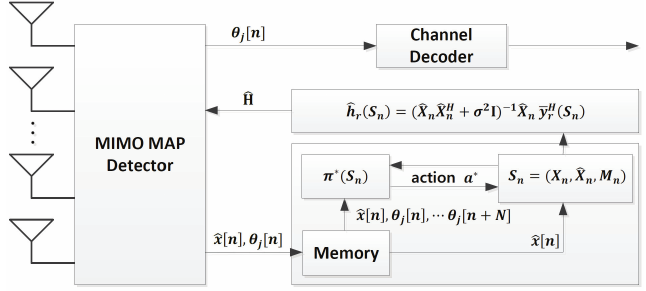
Figure 3. System structure of the proposed data-aided channel